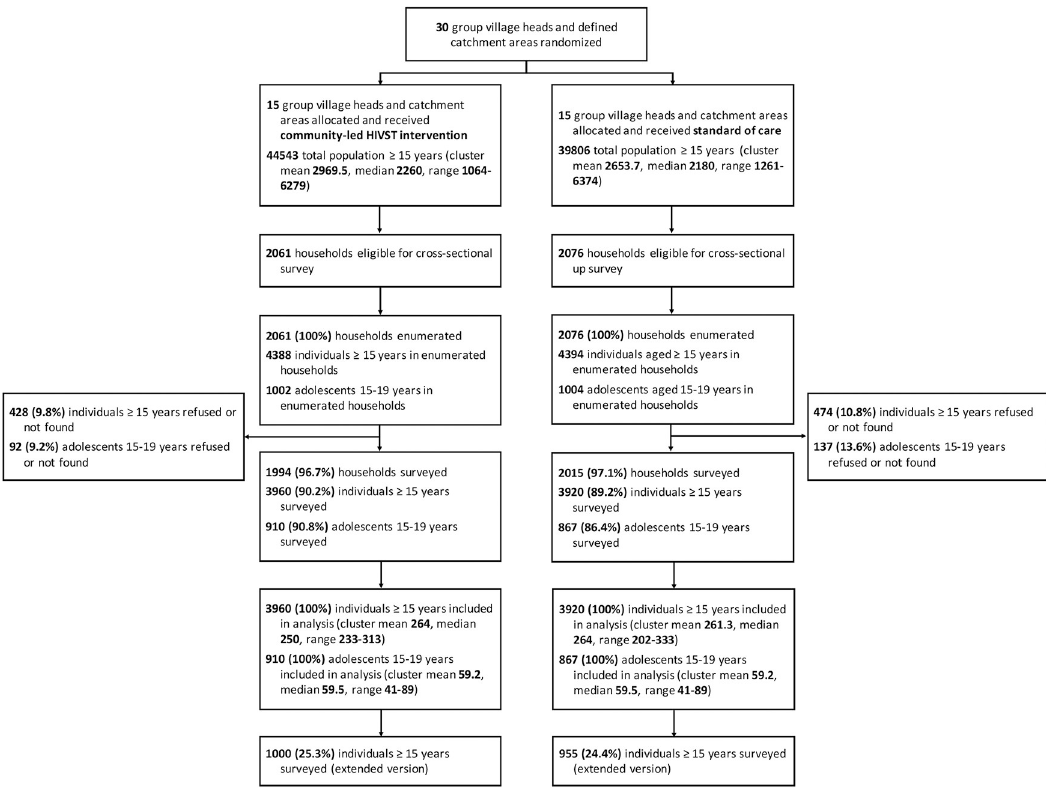
Fig 2. Trial flow diagram. Flow diagram of the cluster-randomised